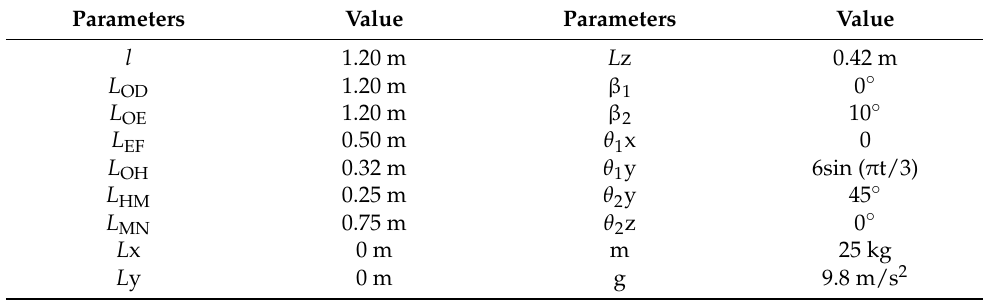
Table 1. The default system